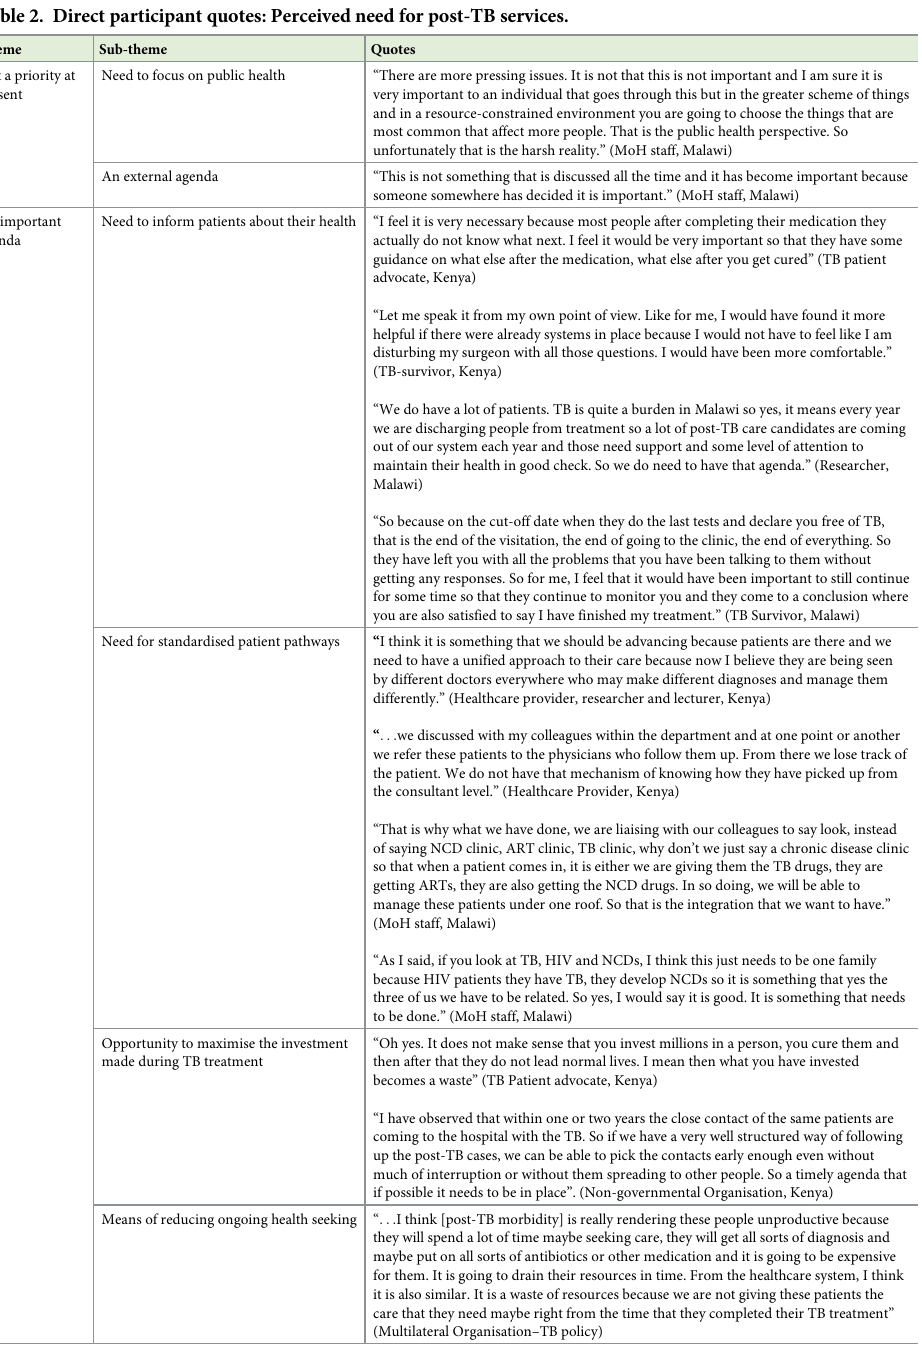
Table 2. Direct participant quotes: Perceived need for post-TB